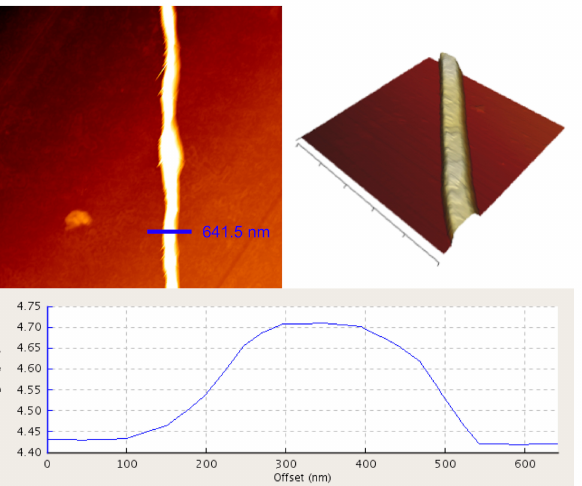
Figure 1. One of the fibres imaged in an atomic force microscope ( left ) with its cross-section plot ( bottom ) and 3D model ( right